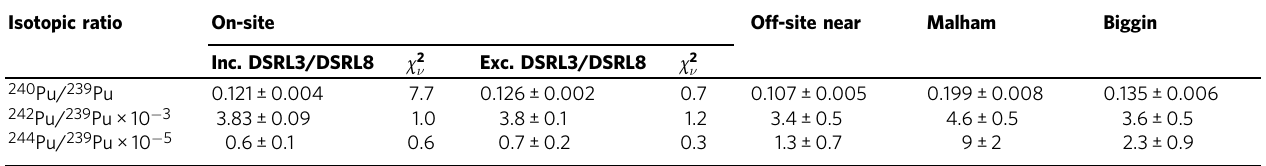
Table 2 Weighted average isotopic ratios for ( 240 Pu/ 239 Pu, 242 Pu/ 239 Pu and 244 Pu/ 239 Pu) for dry